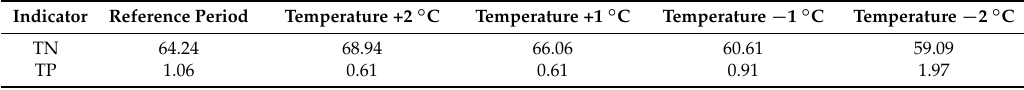
Figure 6. TN load ( a ), TP load ( b ) and average annual temperature variations under the Temperature Change scenario. Table 6. The incidence of water pollution (%) under the Temperature Change scenario.